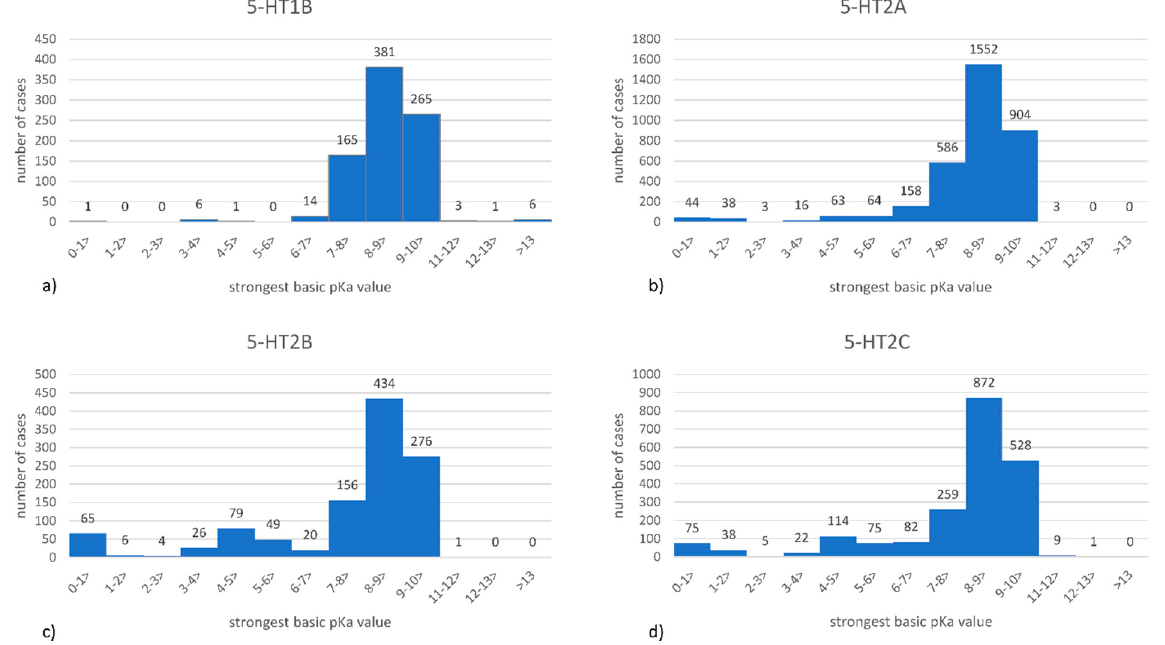
Figure 1. Distribution of pK a values (calculated in InstantJChem as the strongest basic pK a ) for ( a ) 5-HT 1B , ( b ) 5-HT 2A , ( c ) 5-HT 2B , ( d ) 5-HT 2C receptor ligands.